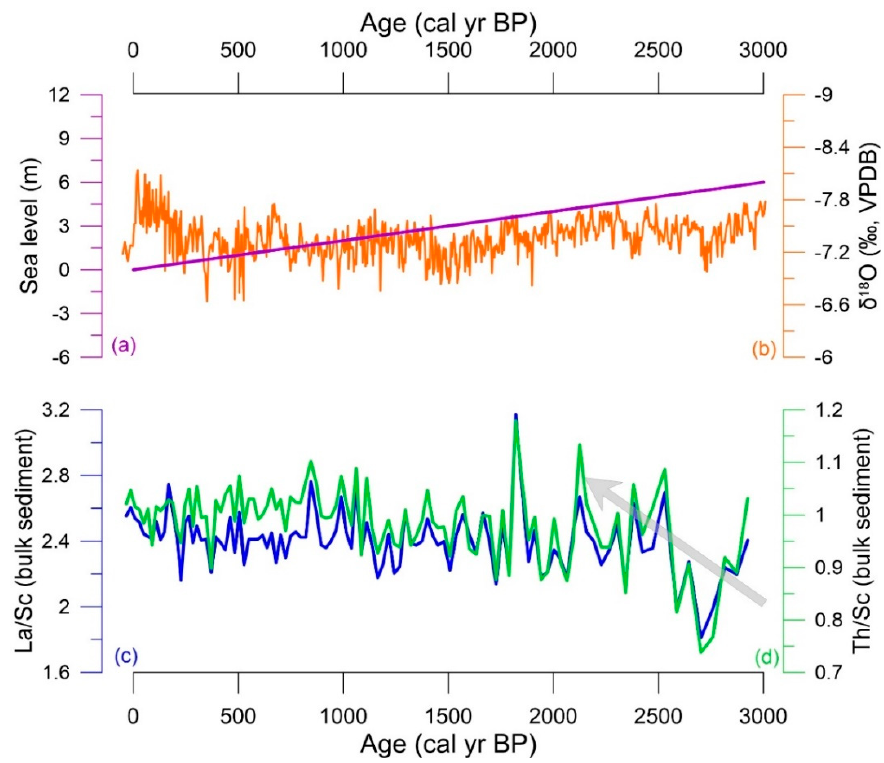
Figure 9. Temporal variations in sea level change [85] ( a ), δ 18 O records of the Dongge Cave stalagmite [86] ( b ), and La/Sc ( c ) and Th/Sc ( d ) of the bulk sediments in Core S3 since 3000 cal. yr BP.